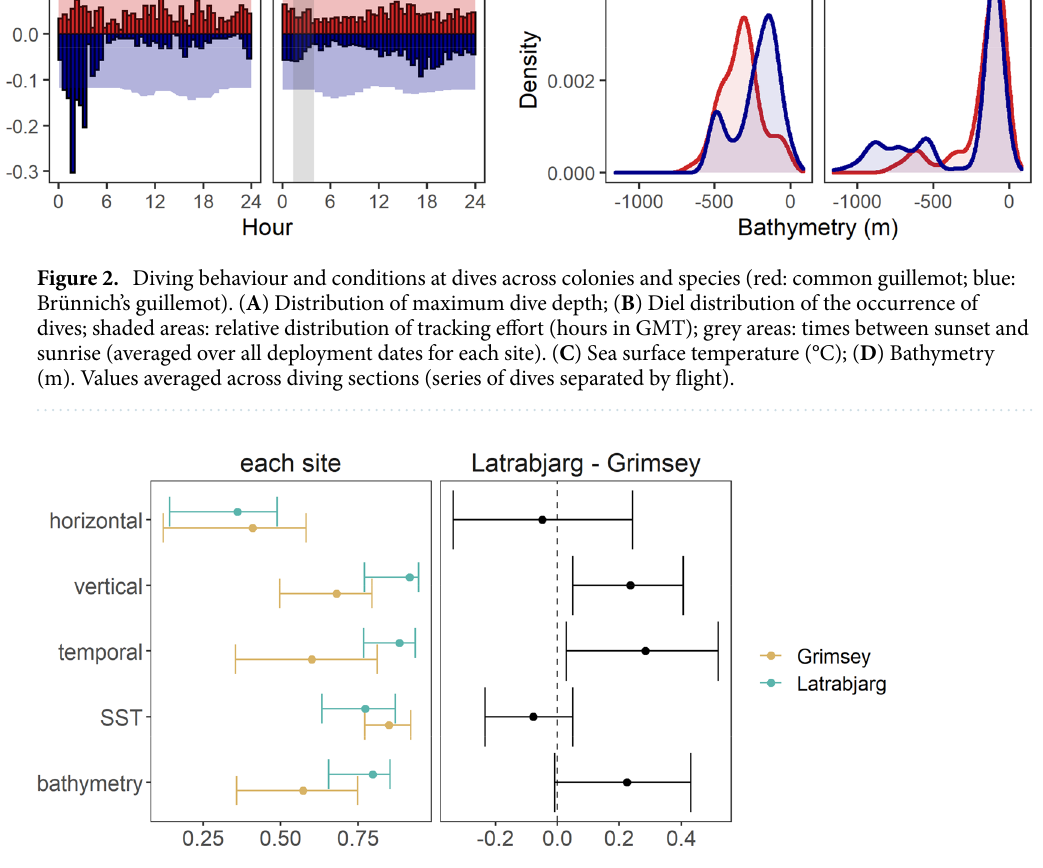
Figure 3. Overlap values at each site (left) and difference between Látrabjarg and Grímsey (right): observed values and bootstrap confidence intervals. Positive values in the right panel correspond to higher overlap at Látrabjarg than at Grímsey (i.e. more segregation at Grímsey). SST = Sea Surface